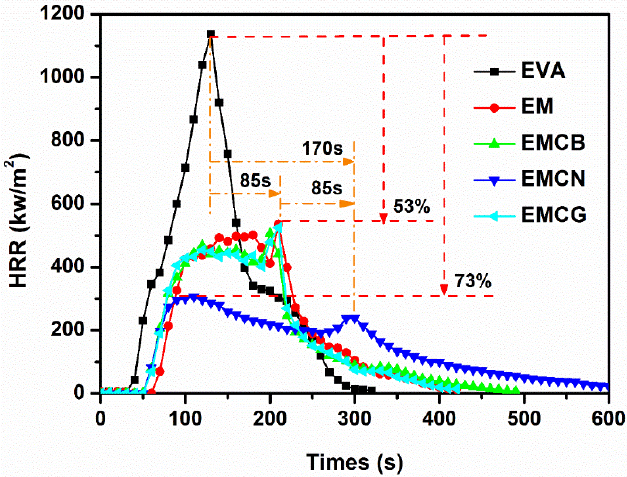
Figure 4. Heat release rate curves of EVA and its composites measured by a cone calorimeter at an external radiant flux of 50 kW/m 2 .